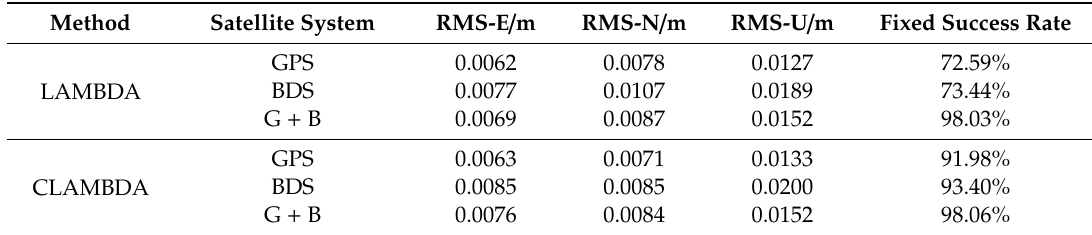
Table 5. Positioning precision